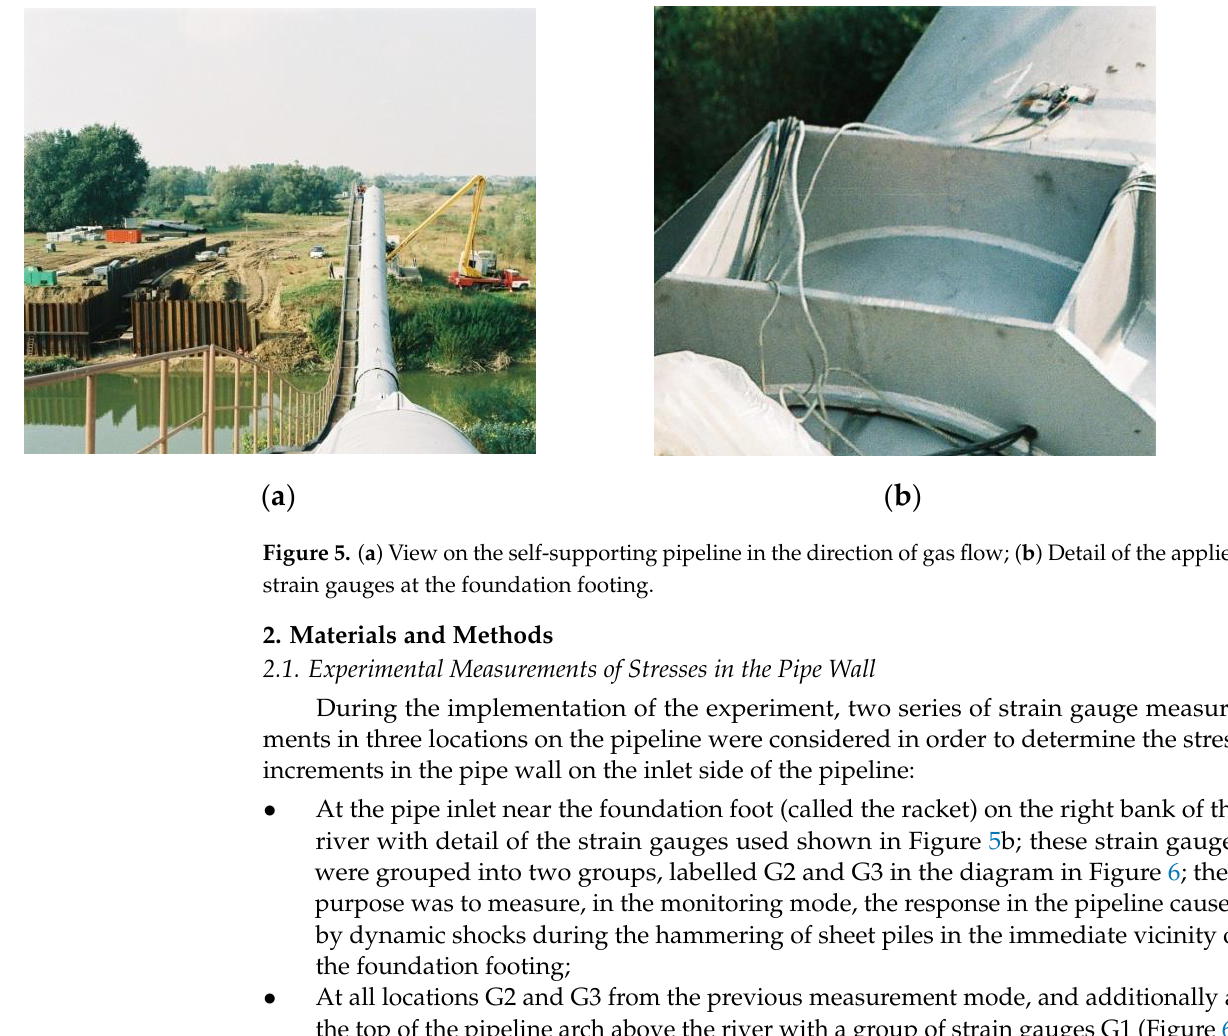
Figure 6. Scheme of the placement of strain gauges on pipes in three groups, G1 to G3. The measuring points or locations for the application of electrical strain gauges were chosen with respect to the results of previous numerical and experimental analyses, as well as considering the possible effect of material bifurcation on the stress in the pipe wall.